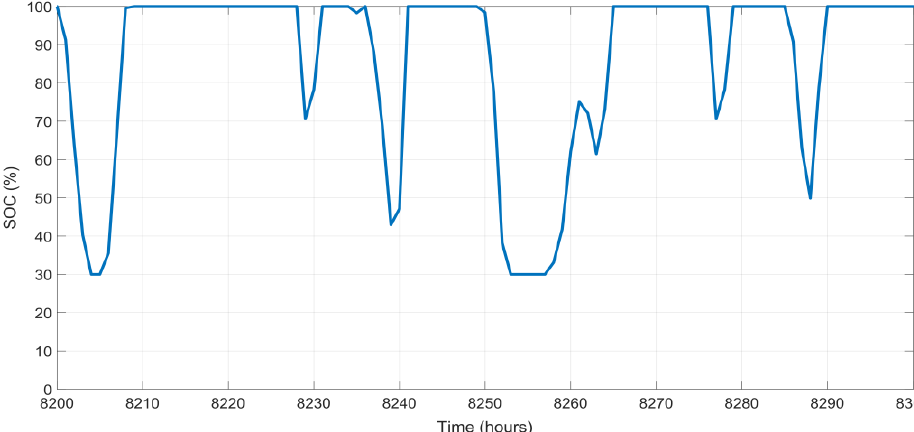
Figure 20. Hourly variation of the battery SOC during the winter season.